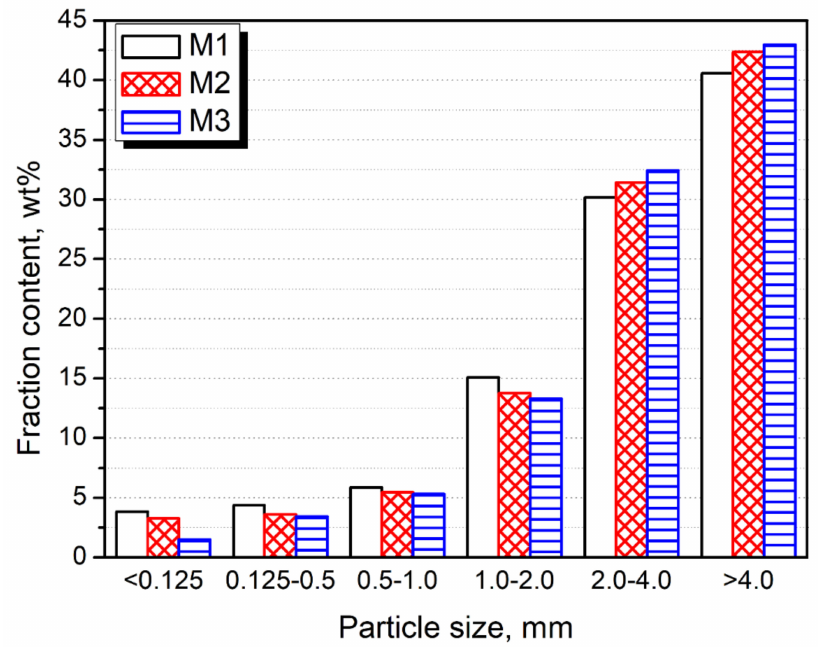
Figure 3. The particle size distribution of analyzed wastes.